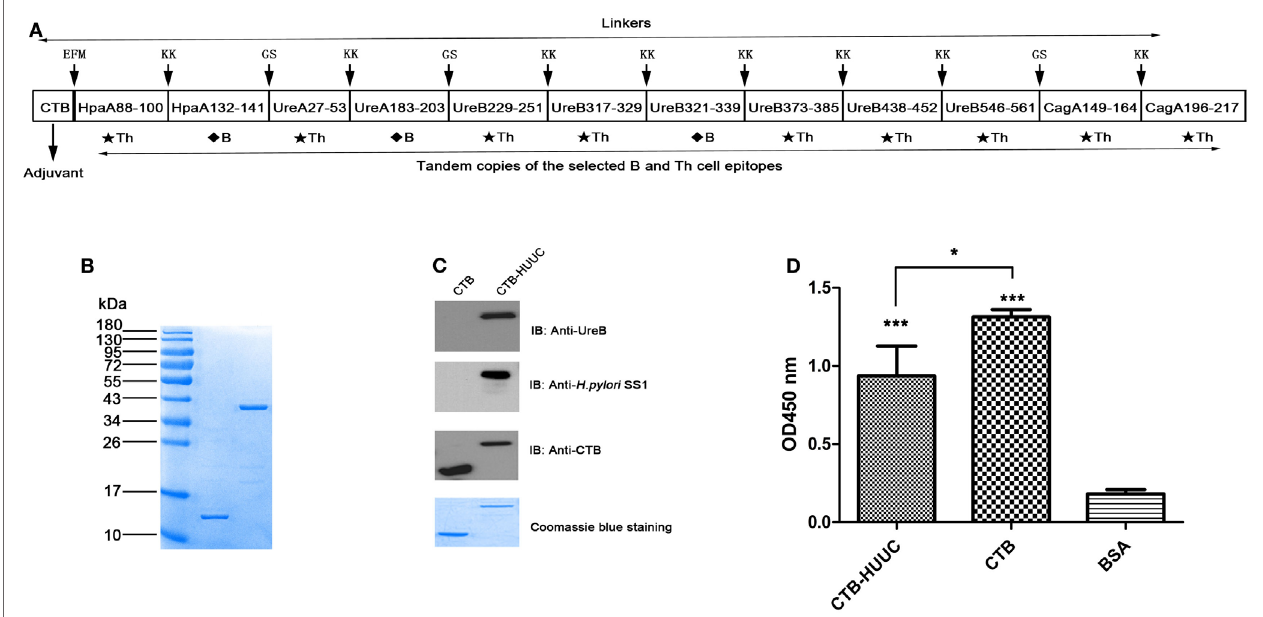
FigUre 1 | Construction, purification, and verification of cholera toxin B subunit (CTB)-HUUC. (a) Composition of the CTB-HUUC construct. (B) Visualization of the purified CTB and CTB-HUUC peptides. CTB and CTB-HUUC peptides purified from Escherichia coli BL21(DE3) transformed with pET28a( + )/ ctB-huuc , pET28a( + )/ ctB were resolved in 12% SDS-PAGE gel and stained with Coomassie Blue. (c) Identity verification of CTB and CTB-HUUC using Western blotting. CTB and CTB-HUUC peptides resolved in 12% SDS-PAGE gels were probed with rabbit anti- Helicobacter pylori polyclonal antibody, rabbit anti-urease B subunit monoclonal antibody, or mouse anti-CTB monoclonal antibody. (D) The adjuvanticity of CTB-HUUC peptide was evaluated using GM1-ELISA. *** p < 0.001, compared with the BSA group, * p < 0.05, compared between the CTB and CTB-HUUC